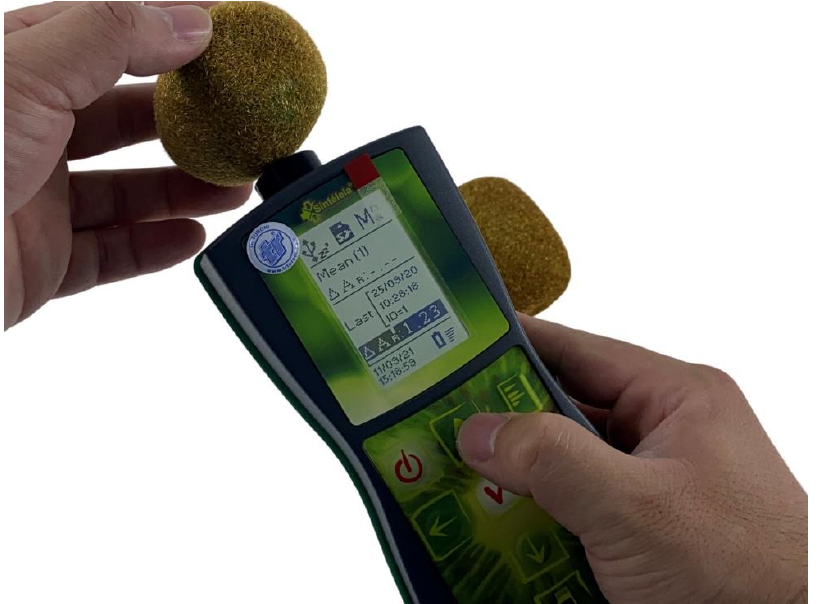
Figure 1. The Kiwi-Meter instrument (T.R. Turoni Inc., Italy) with kiwifruit model used for I AD data measurement.